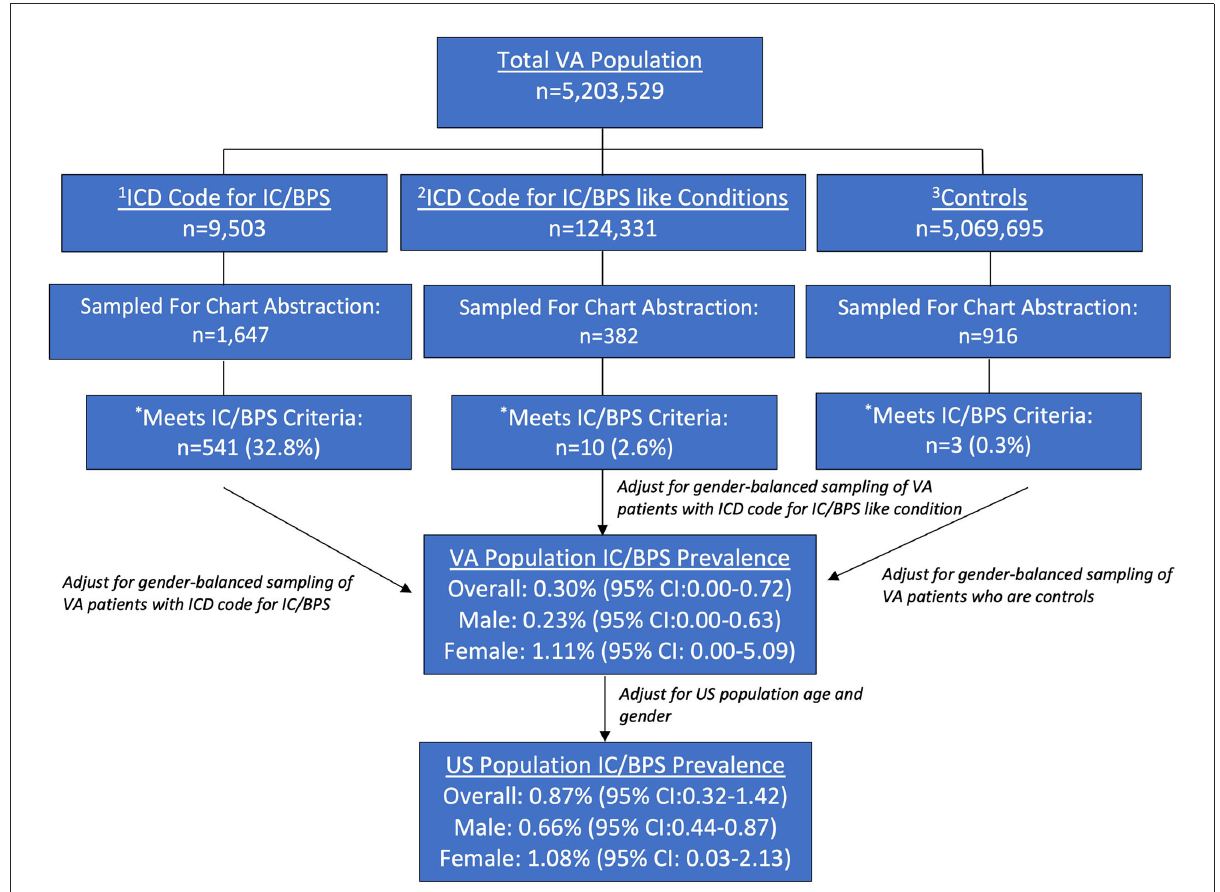
FIGURE1 Estimated prevalence of IC/BPS in the VHA and US Population. 1 ICD-9 and ICD-10 diagnosis of IC/BPS (595.1/N30.10). 2 IC/BPS- “like” conditions which include prostatitis dyspareunia, vaginismus vulvodynia, and vulvar vestibulitis. 3 Defined as all patients not meeting criteria 1 and 2. *Criteria for diagnosis of